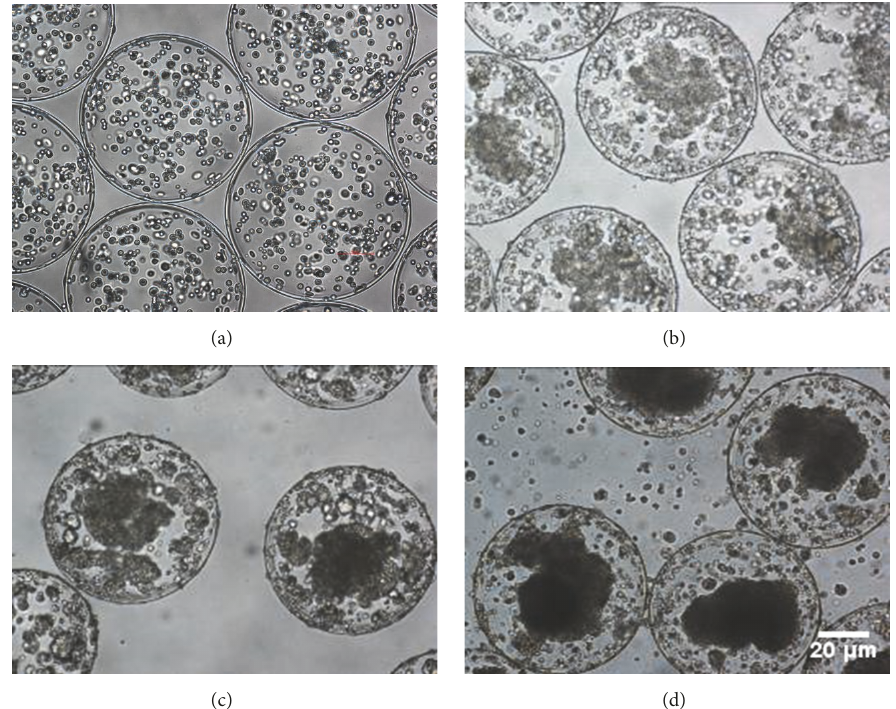
Figure 1: Phase contrast imaging of microencapsulated SGC9701 cells. (a) Microencapsulated cells on day 0 as control. (b) After culturing for 7 days, the cells tended to aggregate in spheres. (c) After culturing for 14 days, the spheres expanded rapidly and grew in three dimensions. (d) After culturing for 21 days, the sphere expansion slowed down and spheres showed necrosis in the center. Magnification: